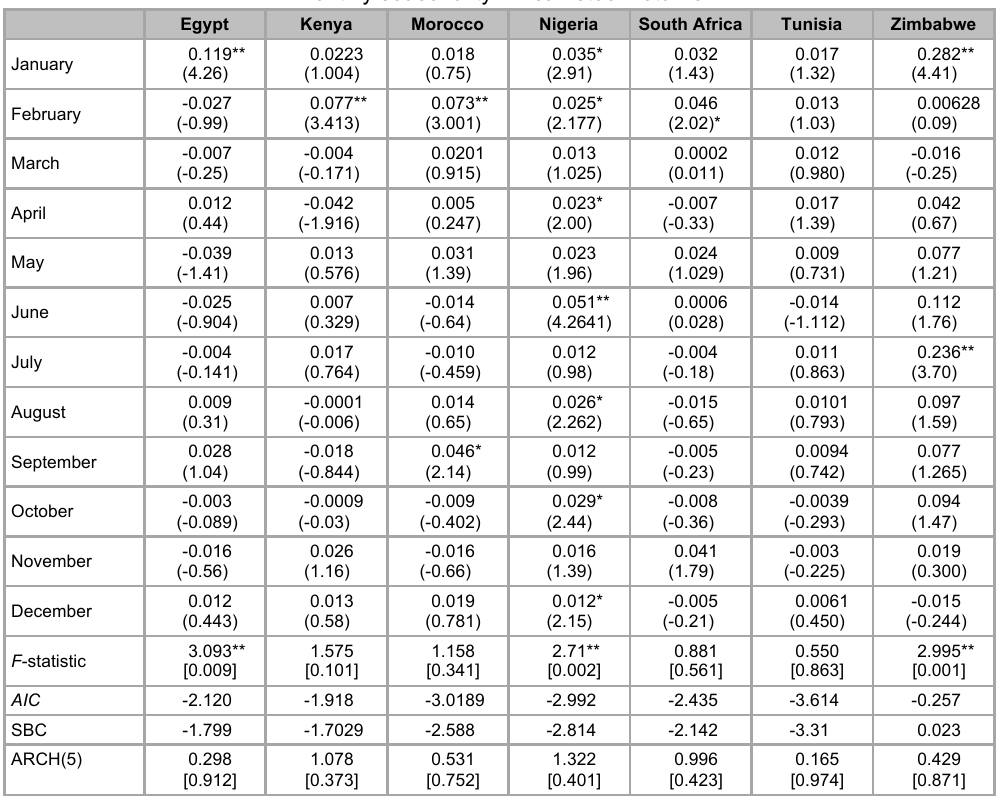
Monthly seasonality African stock